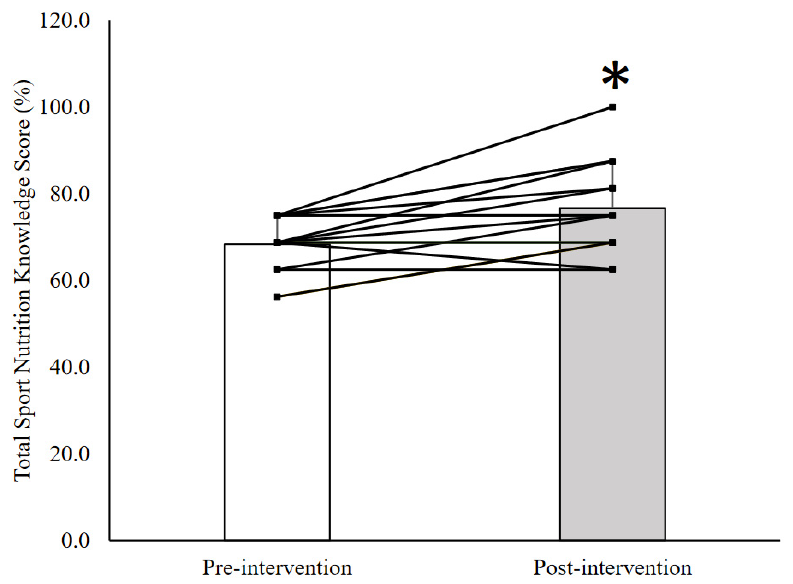
Figure 1. The change in sports nutrition knowledge (SNK) from pre- to post-intervention in highly trained adolescent swimmers. * = a statistically significant change ( p < 0.05).